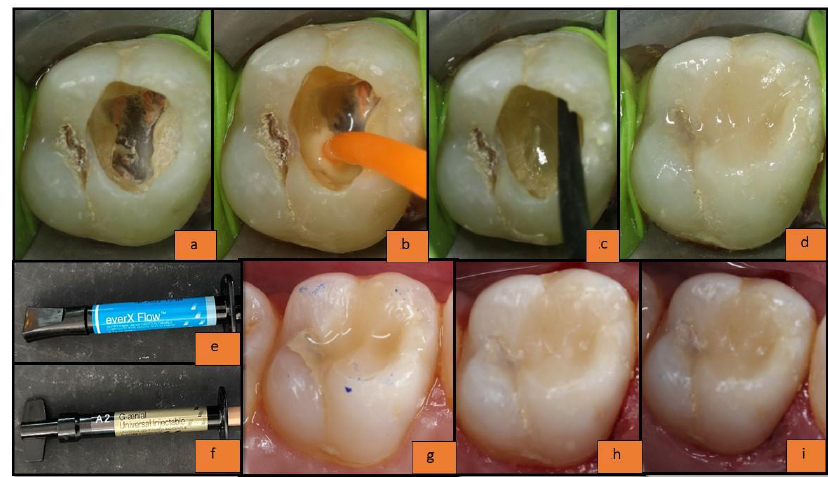
Figure 2. ( a ) Endodontically treated tooth; ( b ) application of universal bonding agent; ( c ) application of everX flow composite; ( d ) application of g-aenial universal injectable composite; ( e ) everX flow composite; ( f ) g-aenial universal injectable composite; ( g ) at baseline; ( h ) 6 months follow-up; ( i ) 1 year follow-up.